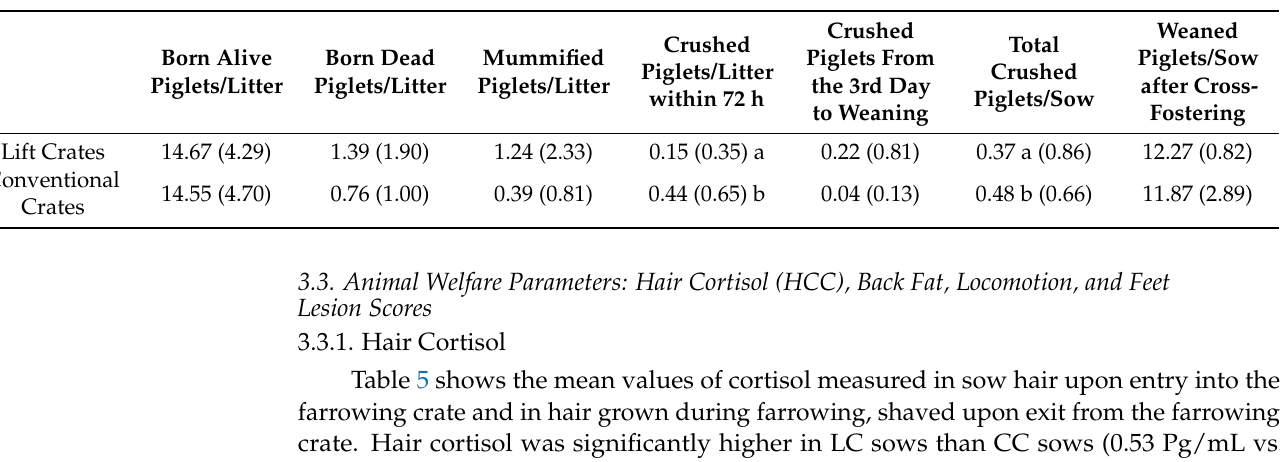
Table 4. Crushed piglets during farrowing. All the litters were cross-fostered within 24 h after parturition; (a, b) data in the same column differ for p < 0.05.